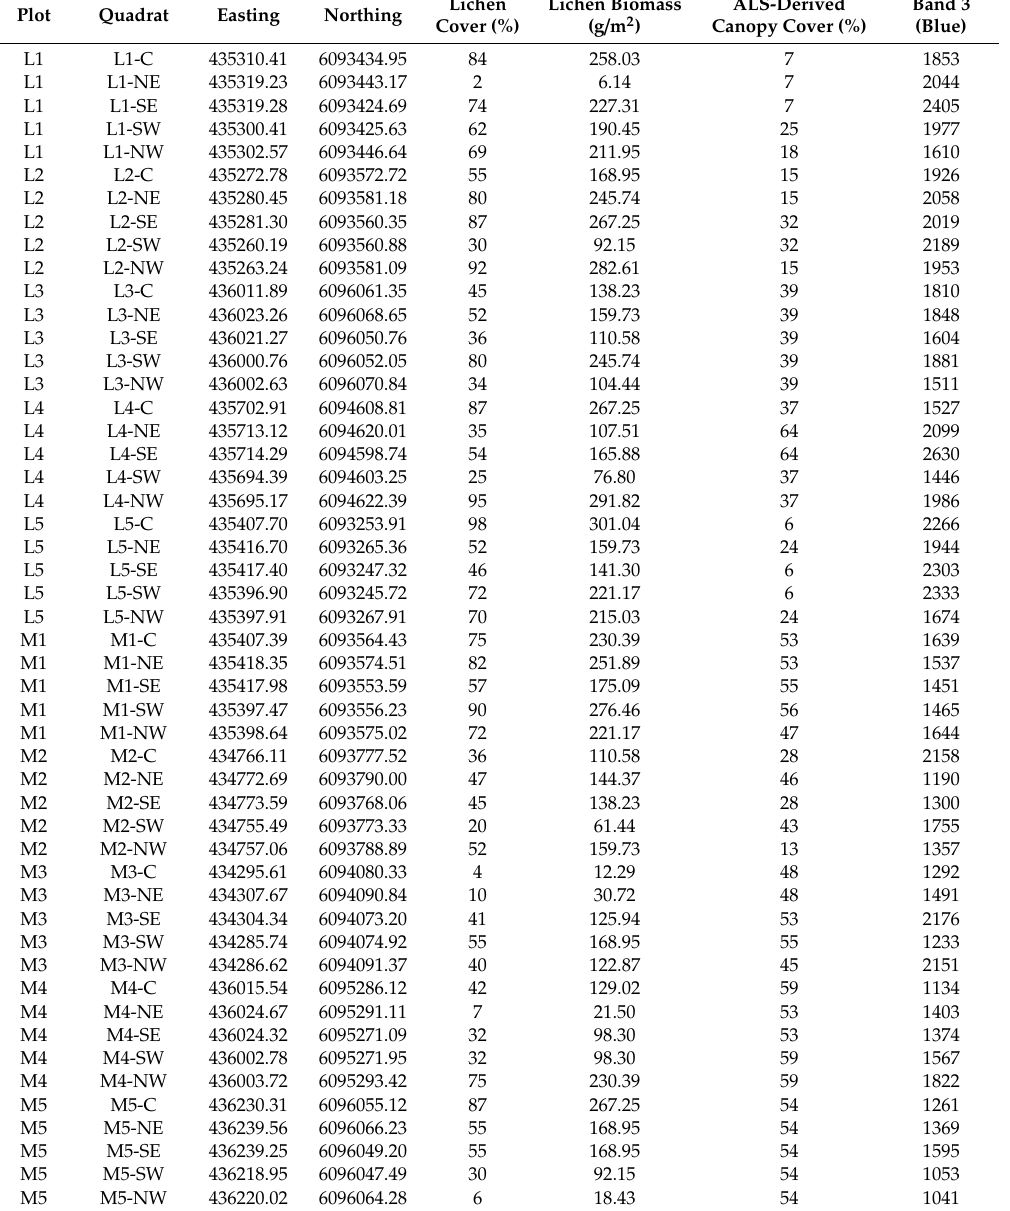
Table A1. Raw field data for surveyed plots. Quadrat location, lichen cover (%), lichen biomass (g / m 2 ), canopy cover derived from ALS (%), and blue band spectral values are provided. Locations are collected in